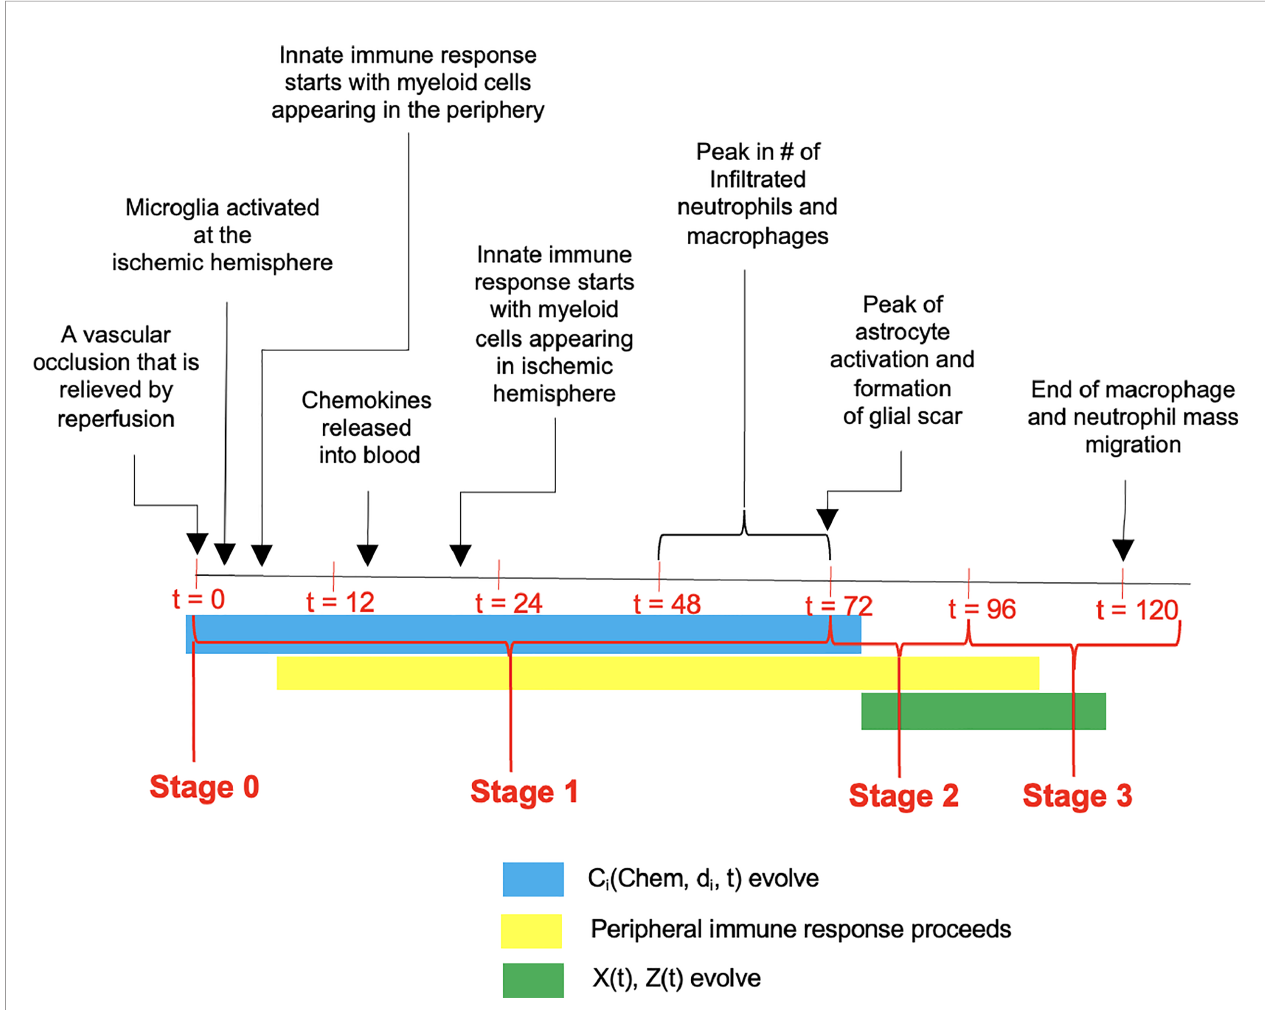
FIGURE 1 | A time-line of events that unfold following the ischemic insult. The progression has been divided into three stages with Stage 0 representing the occlusion, and Stage 1 encompassing the response of the CNS and peripheral immune systems including reduction in microglial population and migration of peripheral innate immune cells into the CNS. Stage 2 is characterized by plateau phase of microglia and in fi ltrated myeloid cells, coupled with continuous in fi ltration of peripheral adaptive immune cells into the CNS. During the stage 3 (i.e., between 96h and 120h post stroke), the in fi ltrated myeloid cells gradually diminish and vanish, while microglial population return back to homeostasis accompanied by persistent presence of adaptive immune cells in the